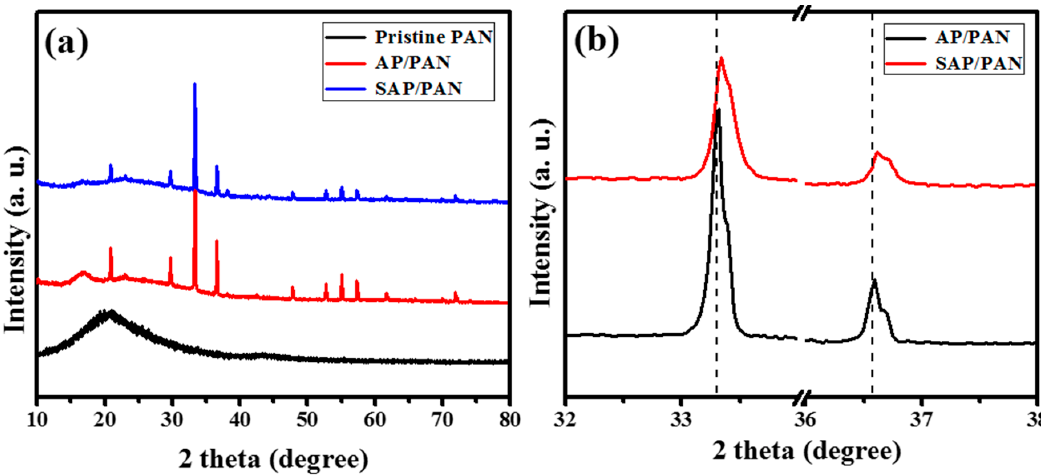
Figure 1. ( a ) XRD diffraction patterns—pristine PAN, AP/PAN, and SAP/PAN; and ( b ) magnified peaks of (210) and (211) crystal planes.